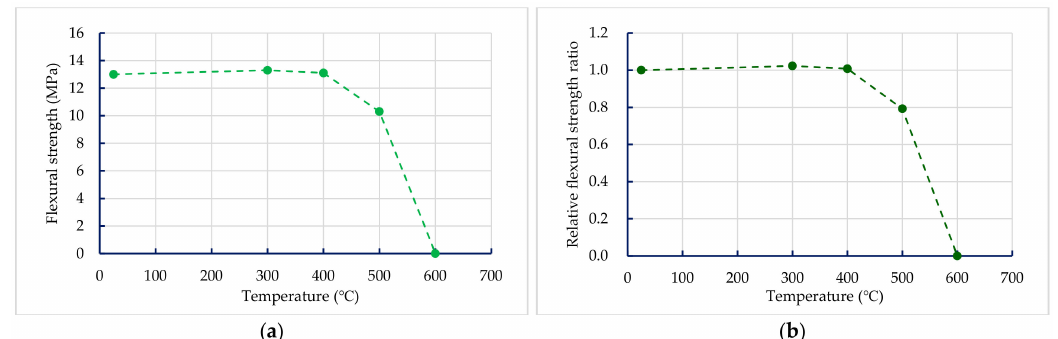
Figure 11. Comparison of flexural strength before and after fire damage to the UHPC-1 specimen: ( a ) residual flexural strength after high temperature; ( b ) relative flexural strength ratio.